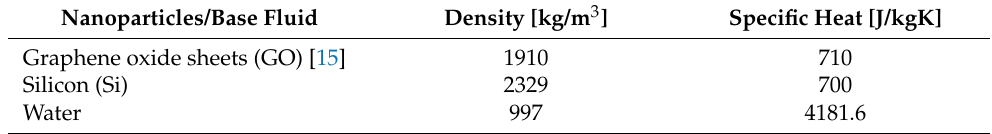
where ϕ is the weight fraction, ρ p is the density of the particles (kg/m 3 ), and ρ bf is the density of the base fluid (kg/m 3 ). The physical properties of base fluid, GO sheets, and Si Table 1. Coefficient values a, b, and 𝑅 (cid:2870) obtained by fitting Equation (1). NPs at 25 ◦ C are described in Table 2. Table 2. The physical properties of base fluid, GO sheets, and Si NPs at 25 ◦ C.